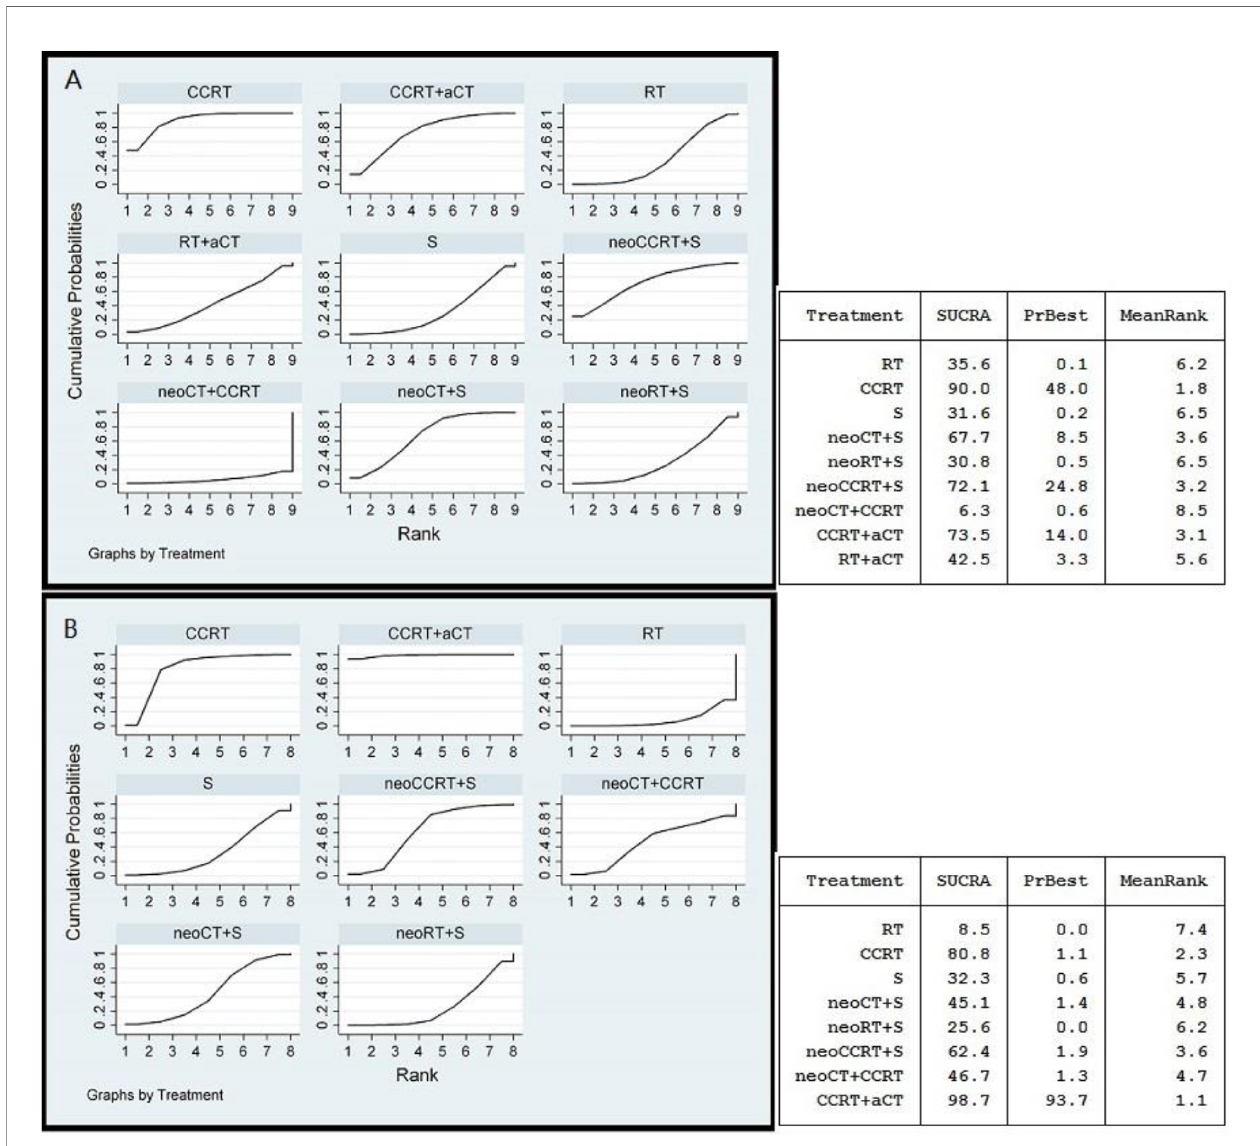
FIGURE 3 | Ranking curves for the overall survival (A) and progression free survival (B) using random effects model. The rankings have been based on the surface under the cumulative ranking (SUCRA) values with the best rank obtained by the modality with the highest SUCRA value. a, adjuvant; neo, neoadjuvant; CCRT, chemoradiotherapy; CT, chemotherapy; RT, radiotherapy; S,